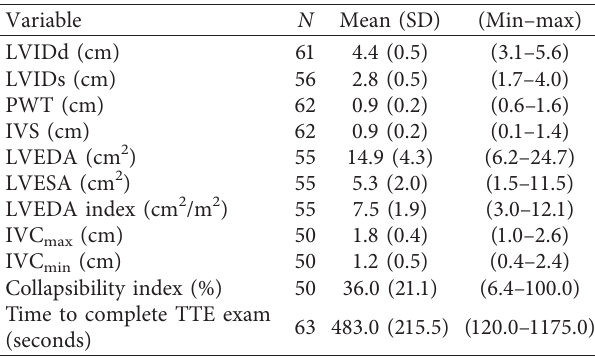
Figure 1: (a) Measurements of left ventricular chamber size and wall thickness dimensions in the parasternal long-axis view during diastole; (b) measurement of the left ventricular chamber size dimension in the parasternal long-axis view during systole. The left ventricular areas are measured at the midpapillary level of the left parasternal short-axis view during both diastole and systole; (c) left ventricular end-diastolic area; (d) left ventricular end-systolic area. LVIDd: left ventricular internal diameter diastole; LVPWd: left ventricular posterior wall diastole; IVSd: interventricular septum diastole; EDV: end-diastolic volume; EF: ejection fraction; LVIDs: left ventricular internal diameter systole; LVEDA: left ventricular end-diastolic area; LVFAC: left ventricular fractional area of change; LVESA: left ventricular end-systolic area. Table 1: Echocardiographic measurements ( n �